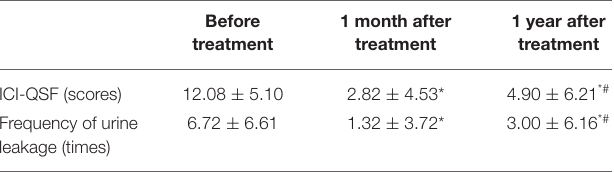
TABLE 3 | The International Consultation on Incontinence Questionnaire-Urinary Incontinence Short Form (ICI-QSF) score and 72-h urine leakage frequency at 1 month and 1 year after treatment with Modified Buzhong Yiqi Decoction ( n = 90).